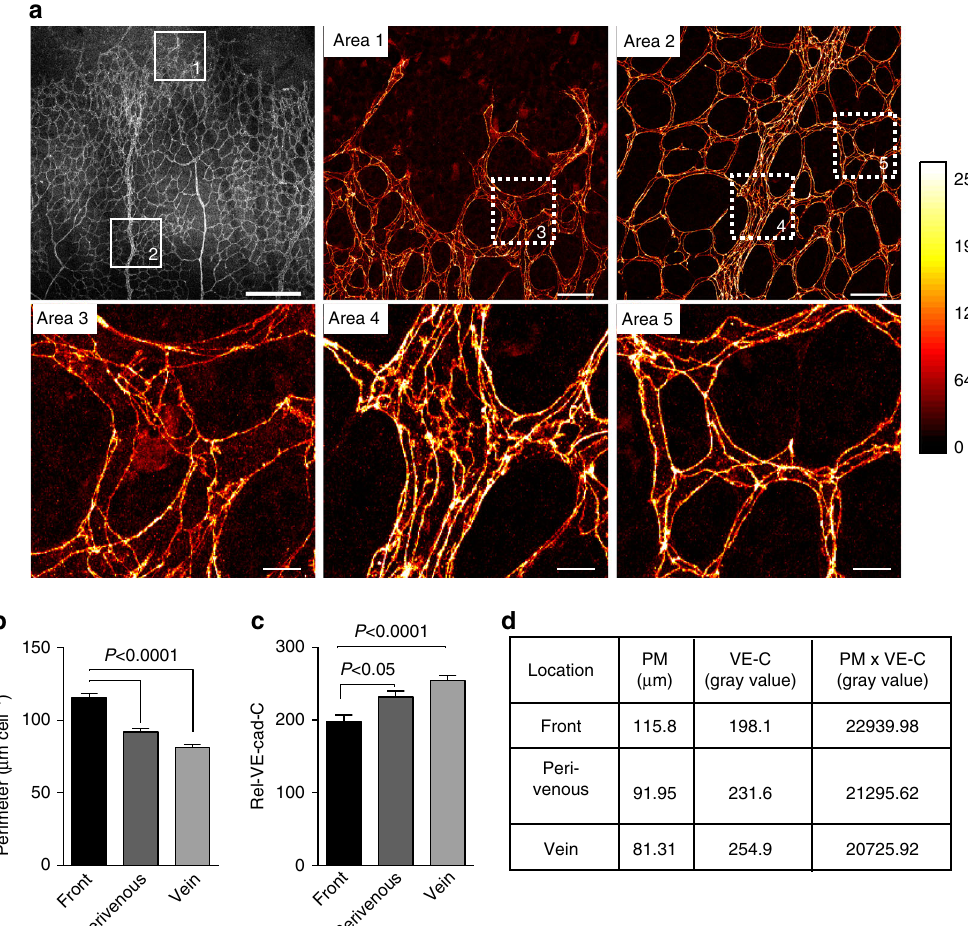
Fig. 1 Migrating front ECs in developing retinas demonstrate an increased perimeter and a reduced Rel-VEcad-C. a Representative heat-map images of VE- cadherin-labelled ECs in front and centre areas of whole-mounted P6 mouse retinas. Area 1 and Area 2 (scale bar: 40 µ m), depicted as indicated, display higher magni fi cations of the angiogenic front and centre vein area, respectively. Area 3 to Area 5 (scale bar: 20 µ m) correspond to the dotted white boxes in Area 1 and 2, respectively. b , c Quanti fi cation of cell perimeter and Rel-VEcad-C in angiogenic front, perivenous plexus in the centre, and vein ECs. Three independent experiments with n cells ( n = 88, 101, and 106) were used for cell perimeter quanti fi cation and ( n = 54, 58, and 75) for Rel-VEcad-C. d Estimation of the total VE-cadherin amount in ECs was performed by multiplying the mean cell perimeter by the mean Rel-VEcad-C. One-way ANOVA was used to analyse the signi fi cance difference. Error bars represent ± SEM. PM perimeter, VE-C